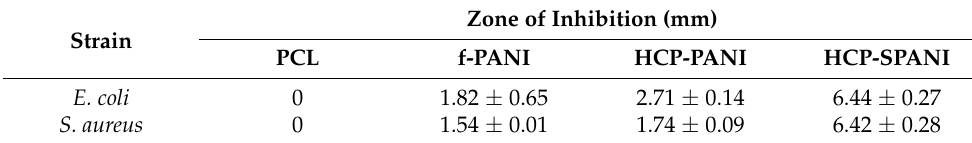
Figure 8. Antibacterial activity of the fabricated films. Disk diffusion assay of fabricated films against ( a ) E. coli and ( b ) S. aureus , and the bacterial growth % of ( c ) E. coli and ( d ) S. aureus on PCL, f-PANI, HCP-PANI, and HCP-SPANI films after 24 h measured at OD (600 nm) . The data are averages of three independent experiments performed in triplicate, **** p < 0.0001. Table 1. The zone of inhibition of the fabricated films against E. coli and S. aureus